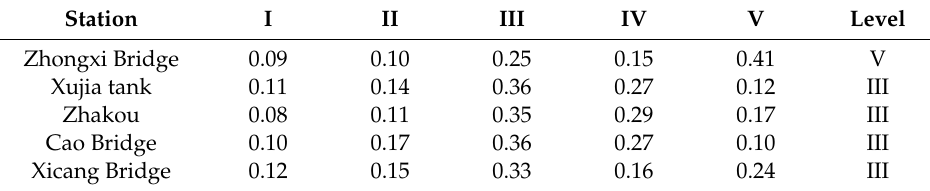
Table 6. Membership degree of the Bayesian method in five stations along the Caoqiao